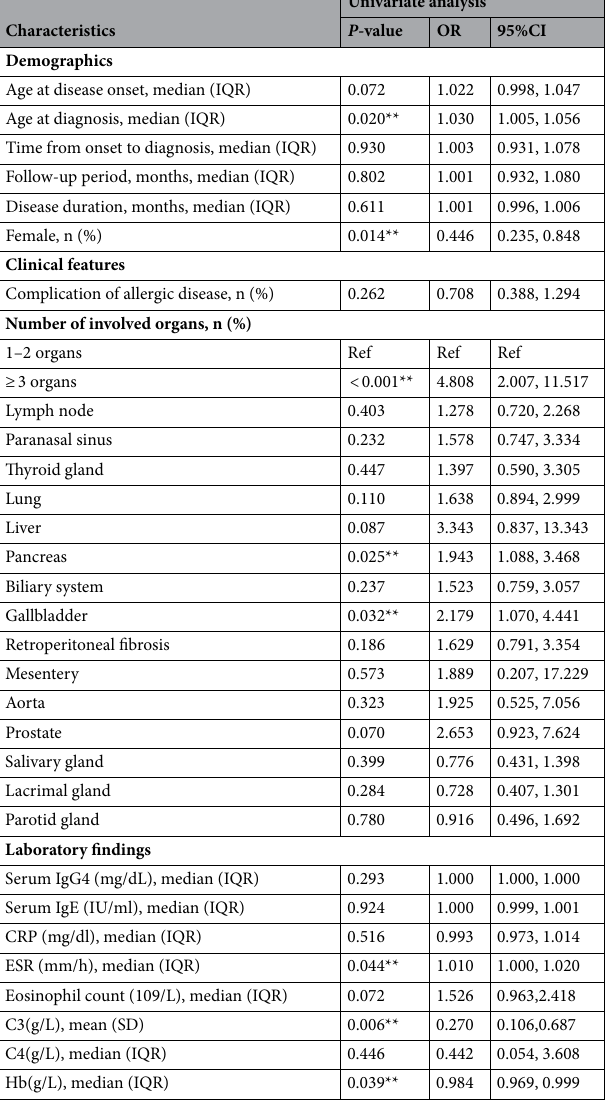
Table 3. Univariate analysis of logistic regression of risk factors for IgG4-RKD+ patients. ** P < 0.05.